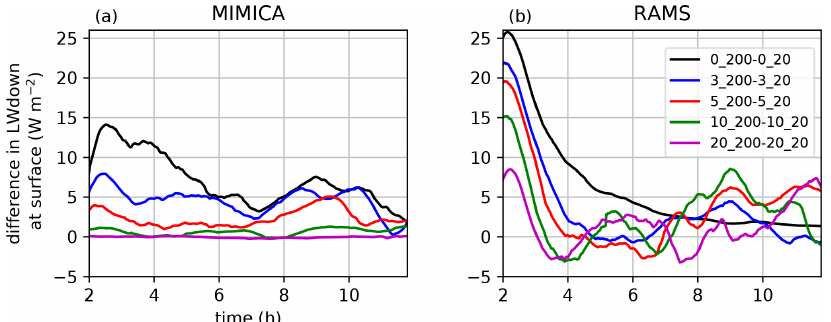
Figure 10. Difference in downward longwave (LWdown) radiation at the surface for simulation pairs with the same accumulation mode concentration (i.e. ACx_AK200–ACx_AK20) shown for (a) MIMICA and (b) RAMS. The first 2h of simulations, considered as the spin-up period, are excluded. A Student’s t test with a 95% confidence level shows that the (time mean) differences are statistically significantly different for each pair of simulations, except for the pair AC20_AK200 and AC20_AK20 in MIMICA. For figure clarity, the plot titles have been abbreviated; the first number refers to the accumulation mode and the second to the Aitken mode concentration in cubic centimetres, i.e. 0_20 refers to